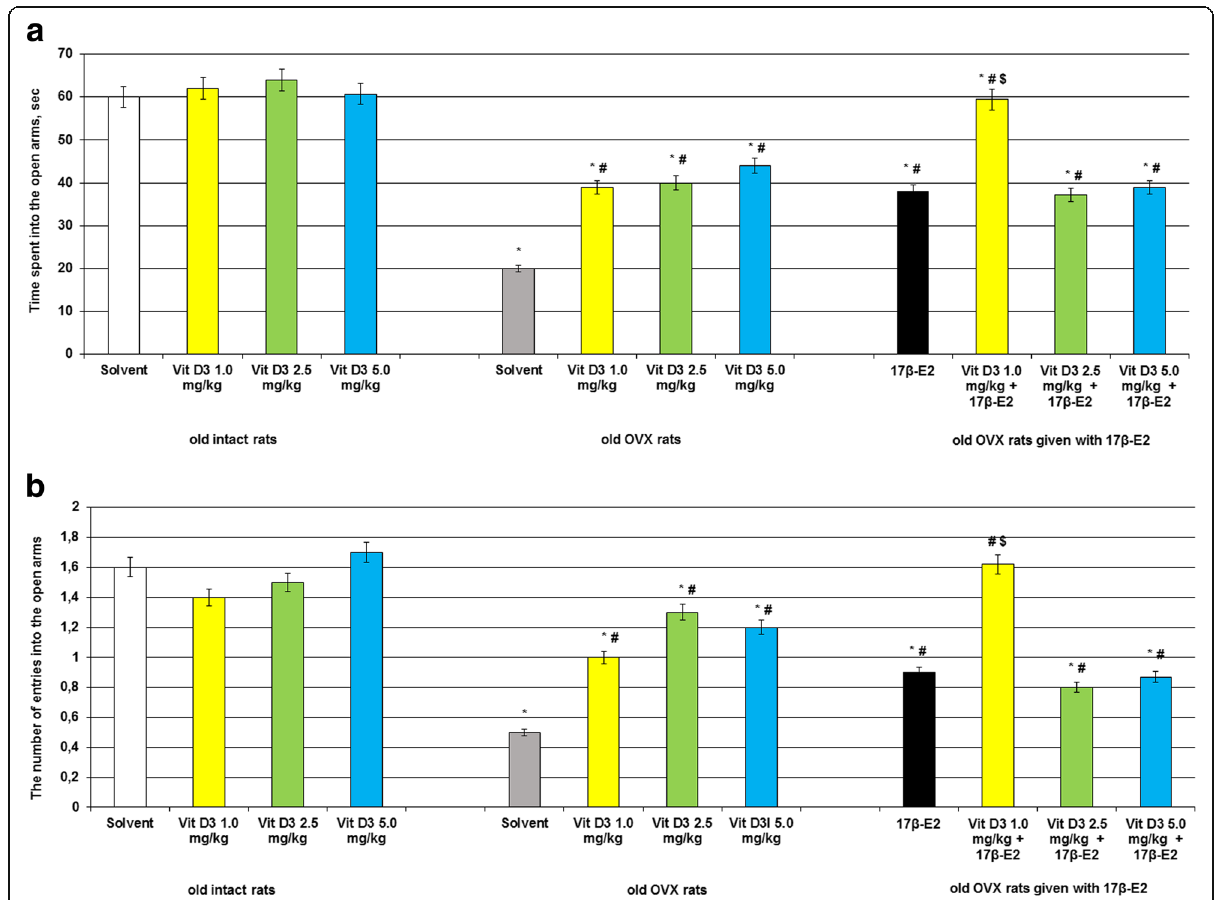
Fig. 1 Effects of Vitamin D 3 administration on anxiety-like behavior of the old ovariectomized (OVX) rats following long-term estrogen deficiency in the elevated plus maze. a – time spent into the open arms, sec; b – the number of entries into the open arms. The obtained results show the mean ± standard error of the mean (SEM). * – p < 0.05 as compared to the control group of the old sham-operated rats; # – p < 0.05 as compared to the old OVX rats treated with solvent; $ – p < 0.05 as compared to the old OVX rats treated with 17 β -estradiol (17 β -E 2 ). Each group comprised a minimum of eight rats. Cholecalciferol was given at 1.0, 2.5 or 5.0 mg/kg/day subcutaneously (s.c.), once daily, for 14 days. The administered dose of 17 β -estradiol was 0.5 μ g/rat s.c., once daily, for